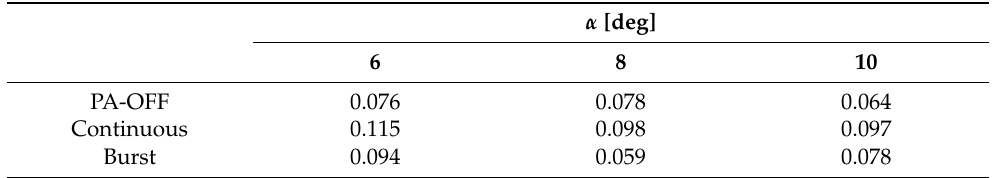
Figure 5. Pressure coefficient ( C p ) distributions around the airfoil in each case of the computations (CFDs) and experiments (EXPs). Table 2. Mean absolute errors (MAE) between the C p distributions obtained by the LESs and the